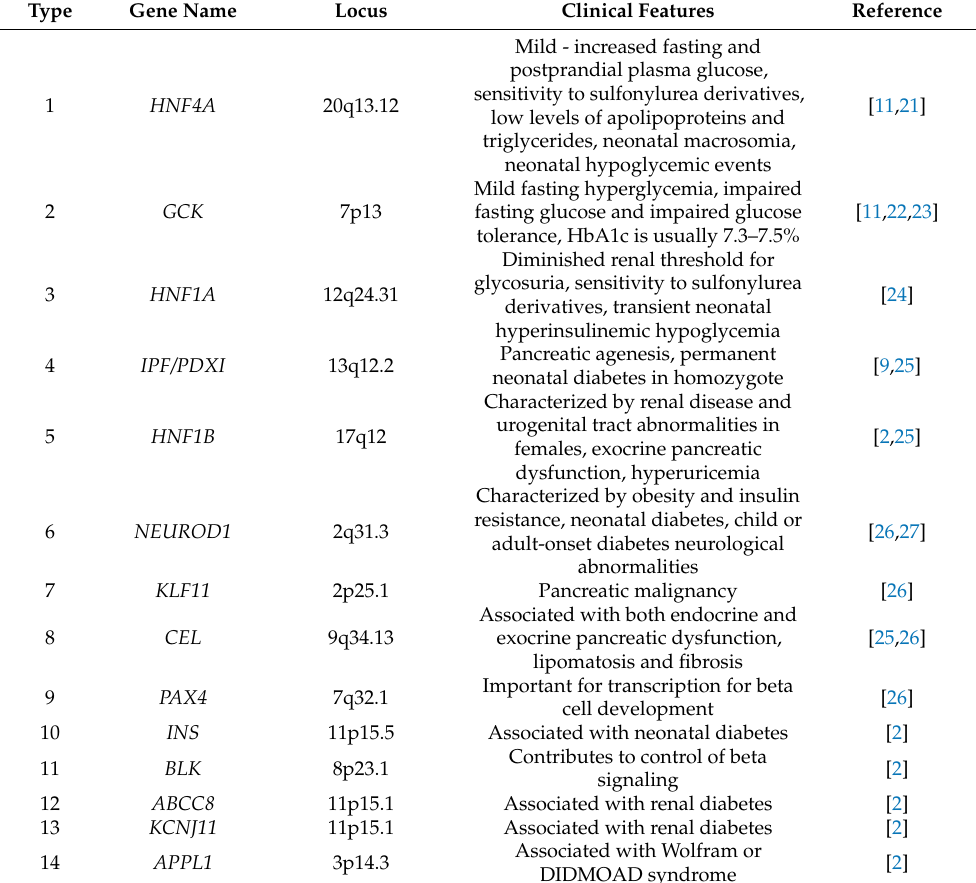
Table 1. Summary of MODY subtypes, gene names, locus, and their clinical